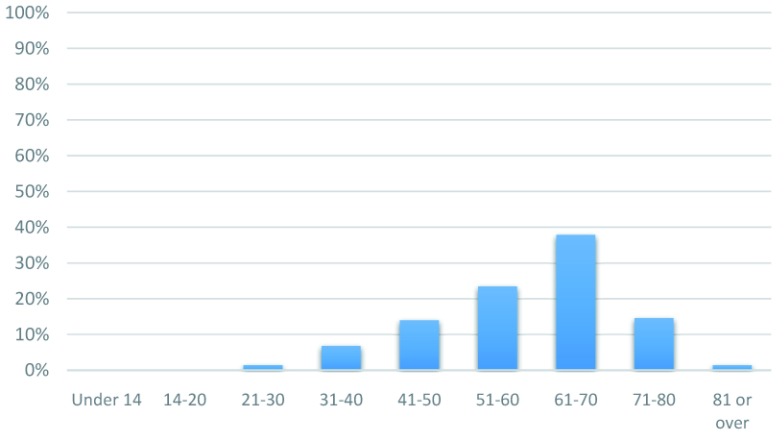
What age are you?